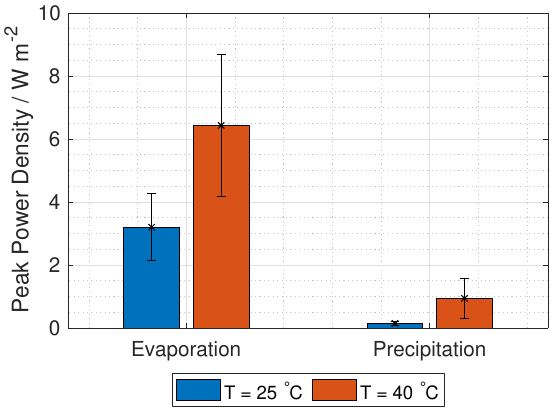
Figure 17. Power density from one RED unit cell (no tafel or electrode losses) per cross-section area using concentrations relevant for the separation techniques evaporation and